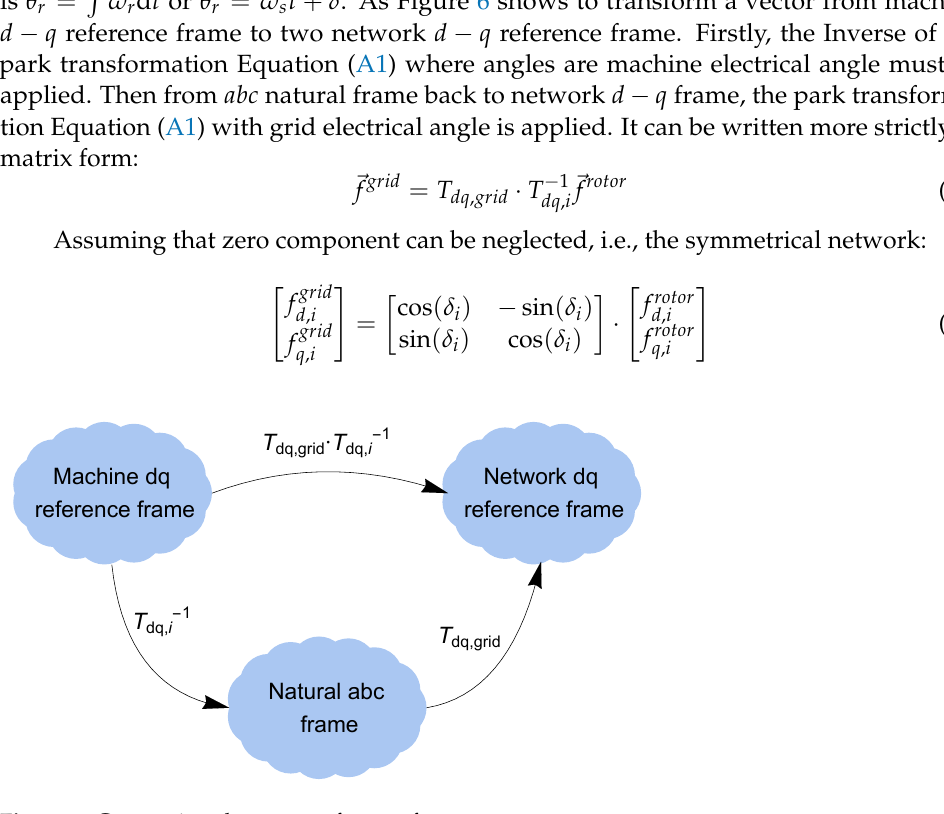
Figure 6. Conversions between reference